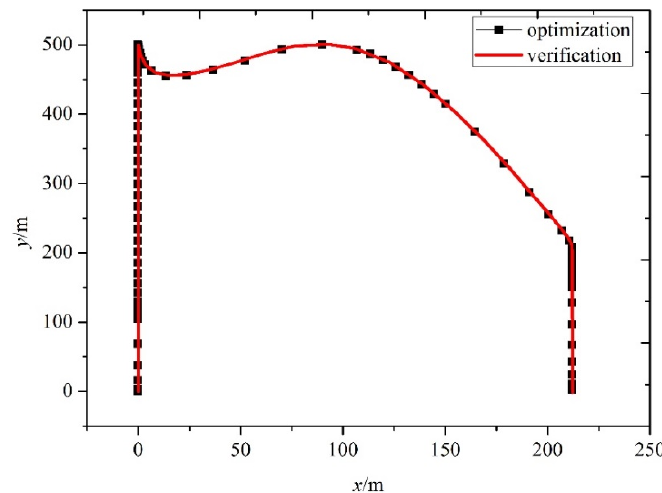
Figure 9. Flight trajectory in the second scenario.